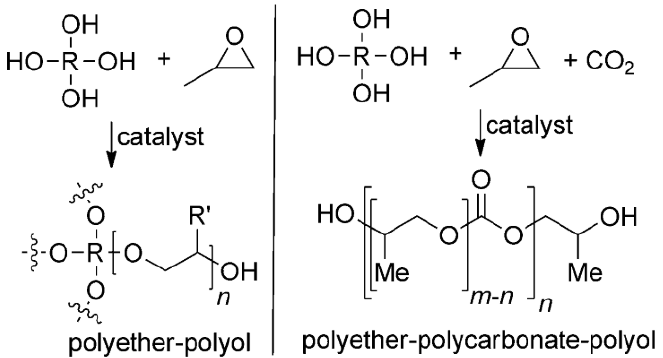
Figure 26. Synthesis of polyols through the traditional reaction scheme and after replacement of propylene oxide units by CO 2 . Reproduced with permission from Arjan W. Kleij, Michael North, Atsushi Urakawa, ChemSusChem; published by John Wiley and Sons, 2017 [516].